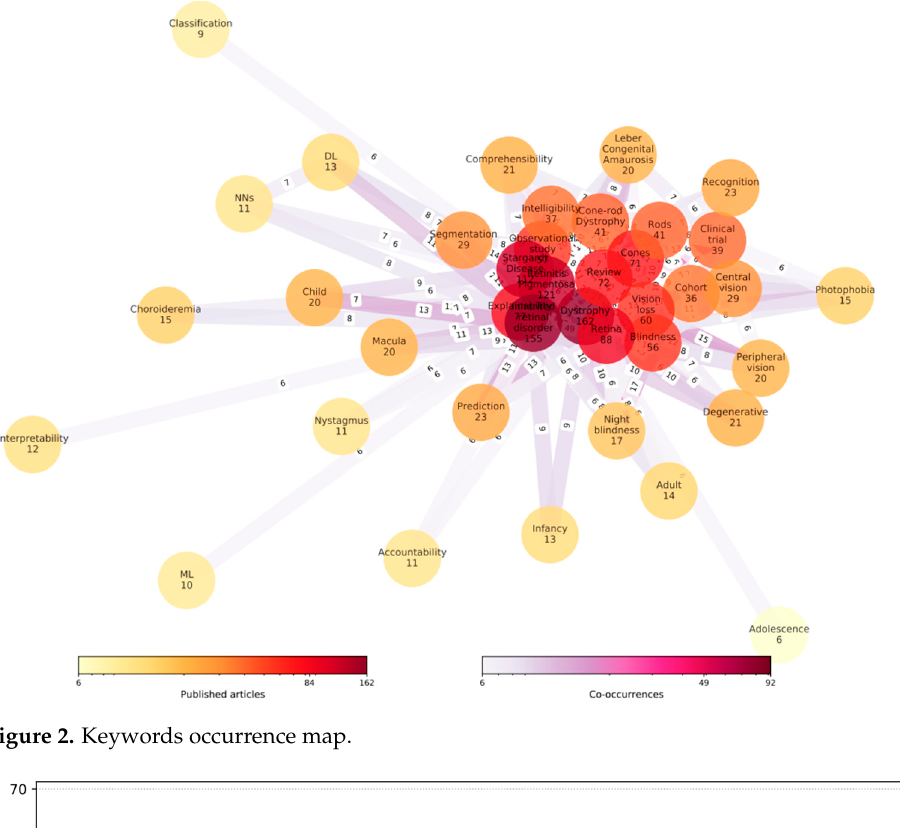
Figure 2. Keywords occurrence map.